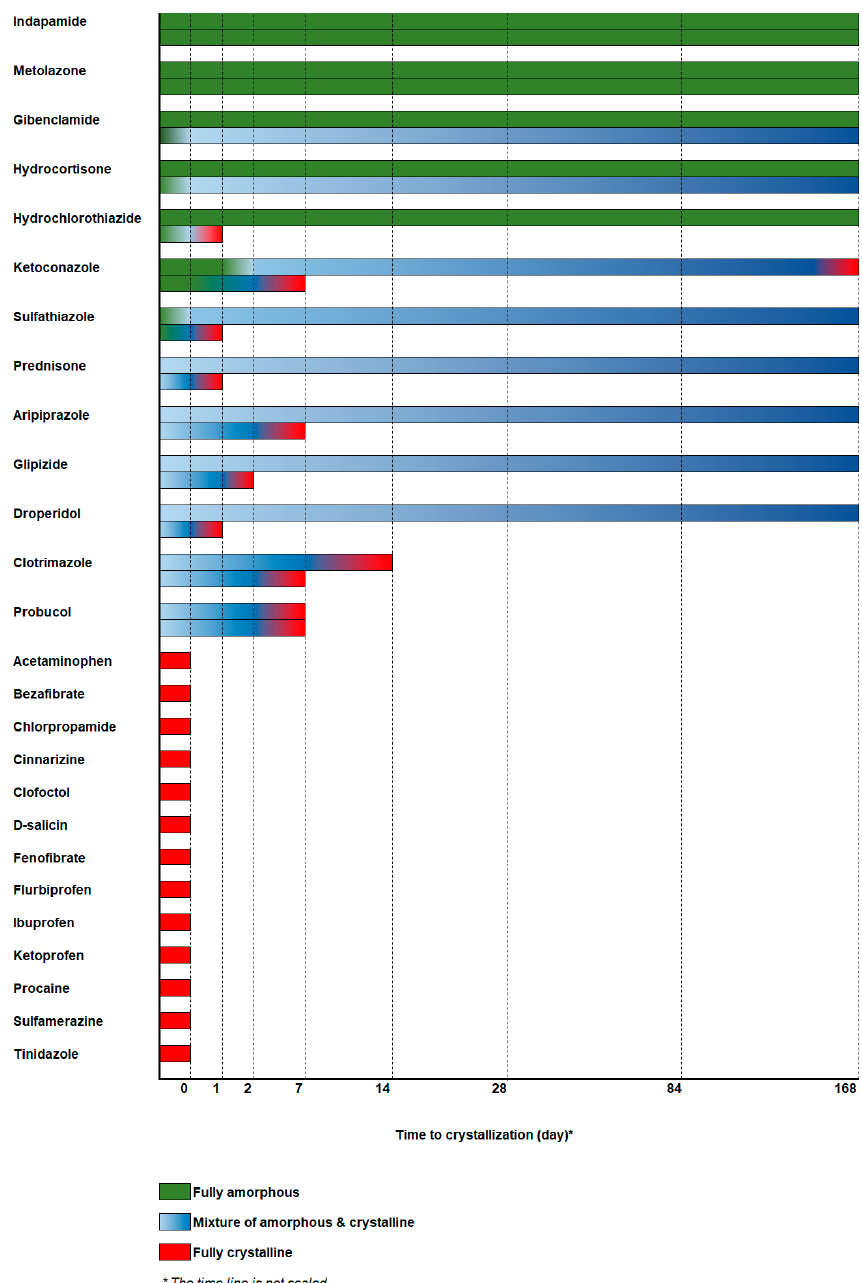
Figure 5. The six-month physical stability of the spray-dried compounds. The stability of each compound is represented by color gradients over the study period: fully amorphous (green), different ratios of amorphous and crystalline mixtures (light to dark blue), and fully crystalline (red). The top and bottom bars for each compound represent the stability under dry conditions (<5% RH) and humid conditions (75% RH), respectively.